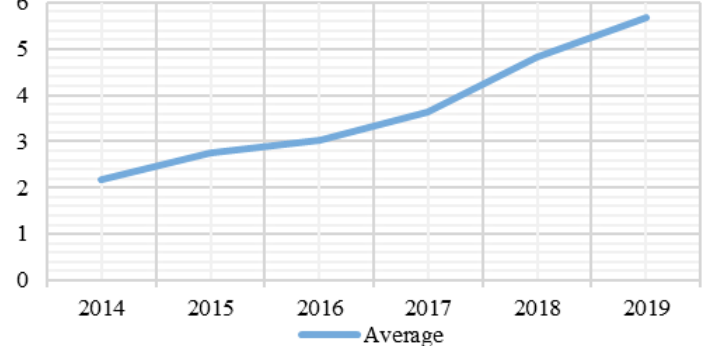
Figure 2. Average USD/TRY exchange rates between 2014-2019